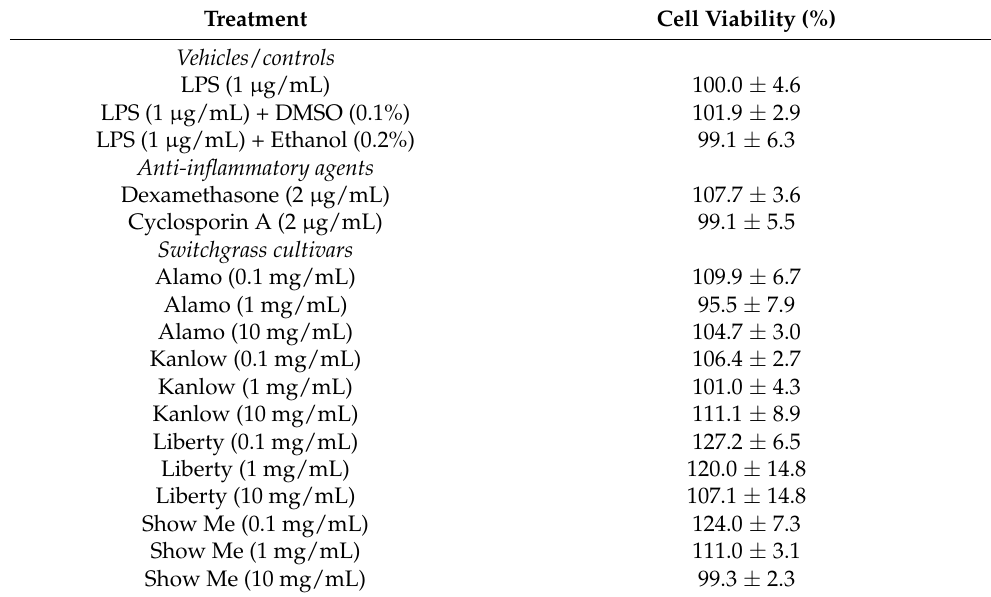
Table 1. Switchgrass extracts, inhibitors, and vehicles exhibited no toxic effects in the U-937 model system. Mean ±